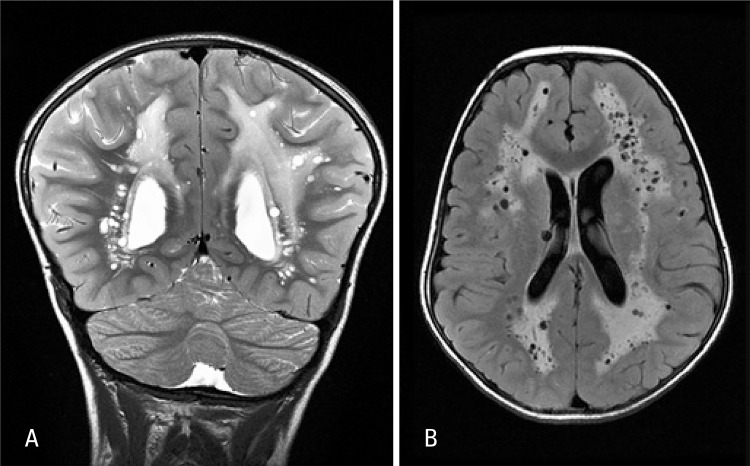
Ressonância magnética coronal T2 (A) e axial fluid attenuated inversion recovery (FLAIR) (B). Hipersinal T2 e FLAIR da substância branca dos hemisférios cerebrais, com predomínio periventricular e central, de forma quase simétrica e difusa. Incontáveis imagens quísticas dispersas por toda a substância branca lesada, em algumas regiões com configuração mais linear, parecendo corresponder à dilatação de espaços perivasculares